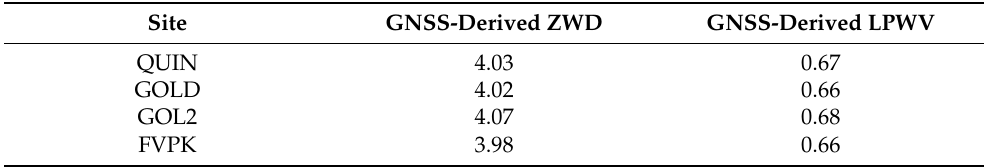
Table 1. The Global Positioning System (GPS) data processing strategy.